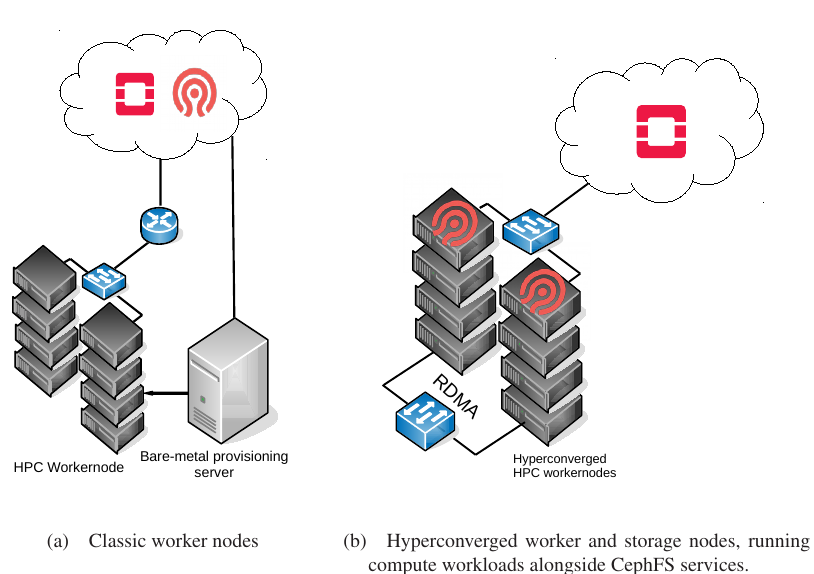
Figure 1: Comparison of classic (a) and hyperconverged (b) worker